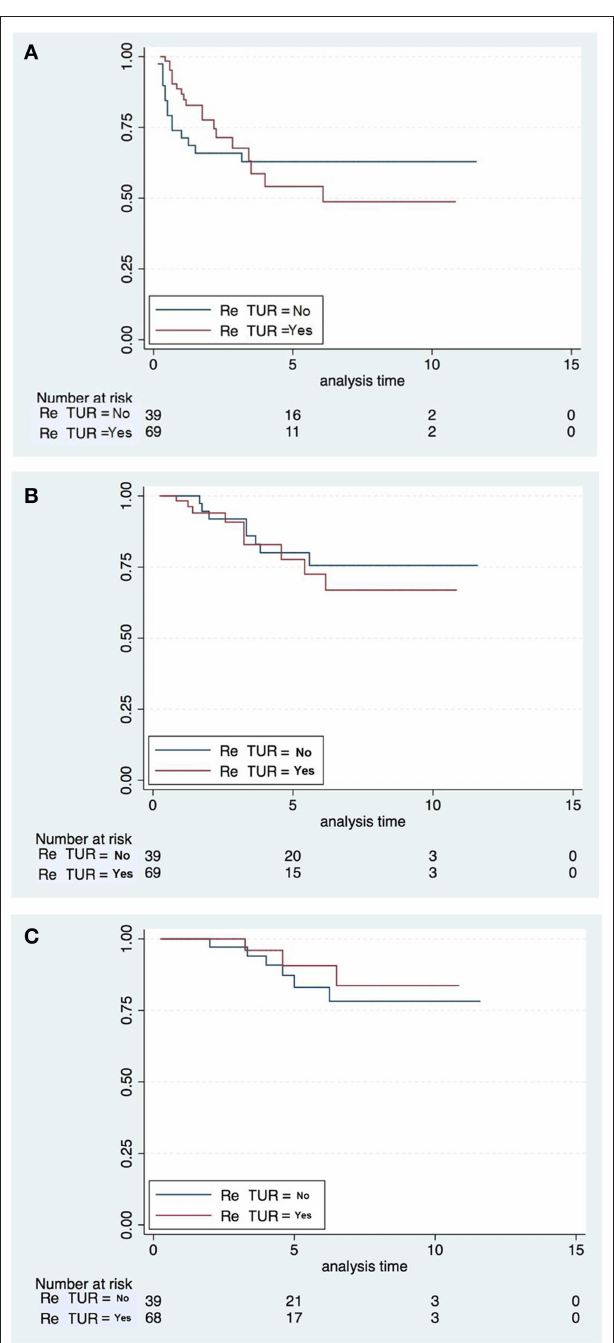
FIGURE 2 | Kaplan-Meier plots for RFS (A) , PFS (B) , and CSS (C) .